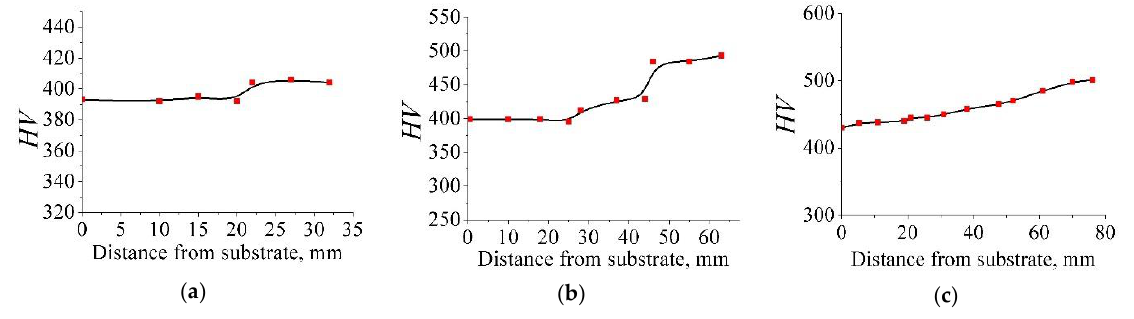
Figure 8. Microhardness measurement results: ( a ) Detail No. 3; ( b ) Detail No. 4; ( c ) Detail No. 5 (deposited part).